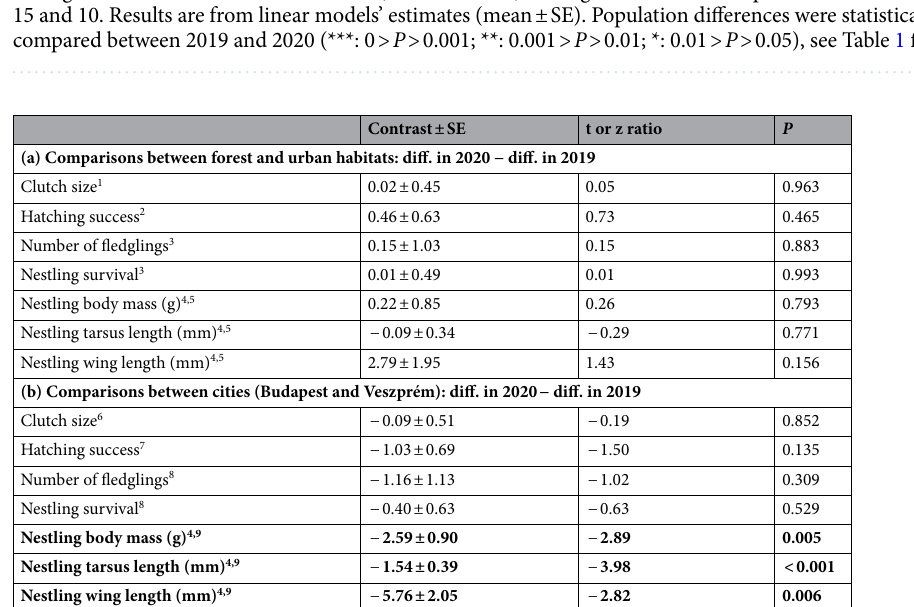
Table 1. Changes in population differences in the reproductive success of great tits between 2019 (reference period) and 2020 (breeding during the lockdown). 1 Number of broods, total: 146; forest (Szentgál): 74, urban (Veszprém): 72. 2 Number of broods, total: 139; forest (Szentgál): 68, urban (Veszprém): 71. 3 Number of broods, total: 134; forest (Szentgál): 64, urban (Veszprém): 70. 4 Results are averaged over the levels of nestlings’ age at ringing (three-level factor). 5 Number of nestlings (broods), total: 488 (84); forest (Szentgál): 215 (33), urban (Veszprém): 273 (51). 6 Number of broods, total: 112; urban (Budapest): 40, urban (Veszprém): 72. 7 Number of broods, total: 107; urban (Budapest): 36, urban (Veszprém): 71. 8 Number of broods, total: 99; urban (Budapest): 29, urban (Veszprém): 70. 9 Number of nestlings and broods, total: 394 (76); urban (Budapest): 121 (25); urban (Veszprém): 273 (51). Population differences were calculated either ( a ) between a forest and an urban habitat (Szentgál minus Veszprém) or ( b ) between two cities (Budapest minus Veszprém). Negative contrasts indicate smaller between-population differences during the 2020 lockdown than in 2019. Model estimated contrast ± SE values are on the original scales except for hatching success (the proportion of hatched chicks/laid eggs) and nestling survival (the proportion of fledged young/hatched chicks), which are given on the log odds ratio scale. Statistically significant results ( P < 0.05) are highlighted in bold. See Table sS1 and S2 for statistical details of the models used for the forest-city and between-cities contrast calculations, respectively.